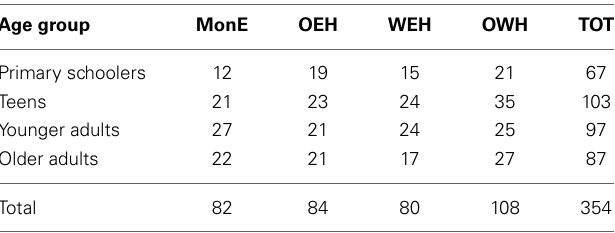
Table 3 | Participants, metalinguistic task, English and